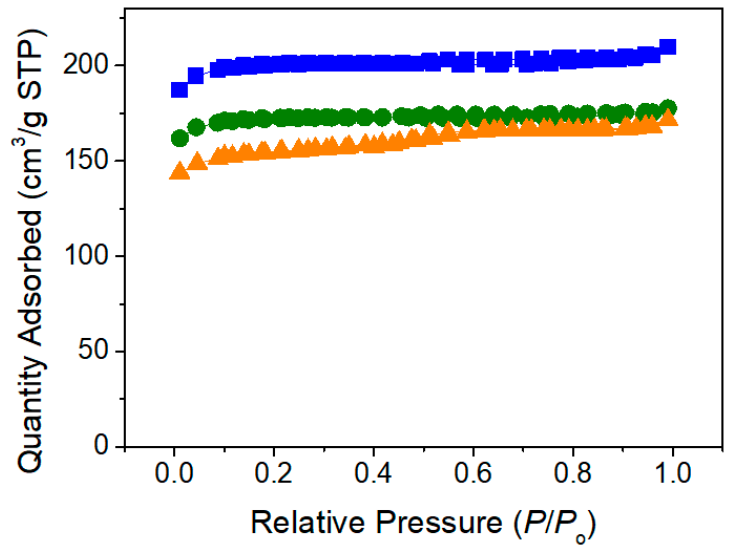
Figure 1. N 2 sorption isotherms of zeolite XZ-Li (- ■ -), XZ-Na (- ● -) and XZ-K (- ▲ -).